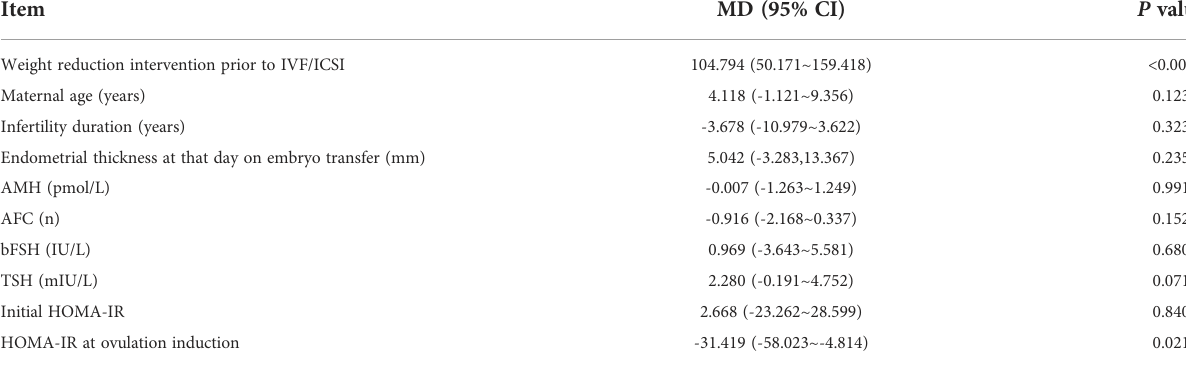
TABLE 4 Linear regression analysis of the in fl uencing factors of birth